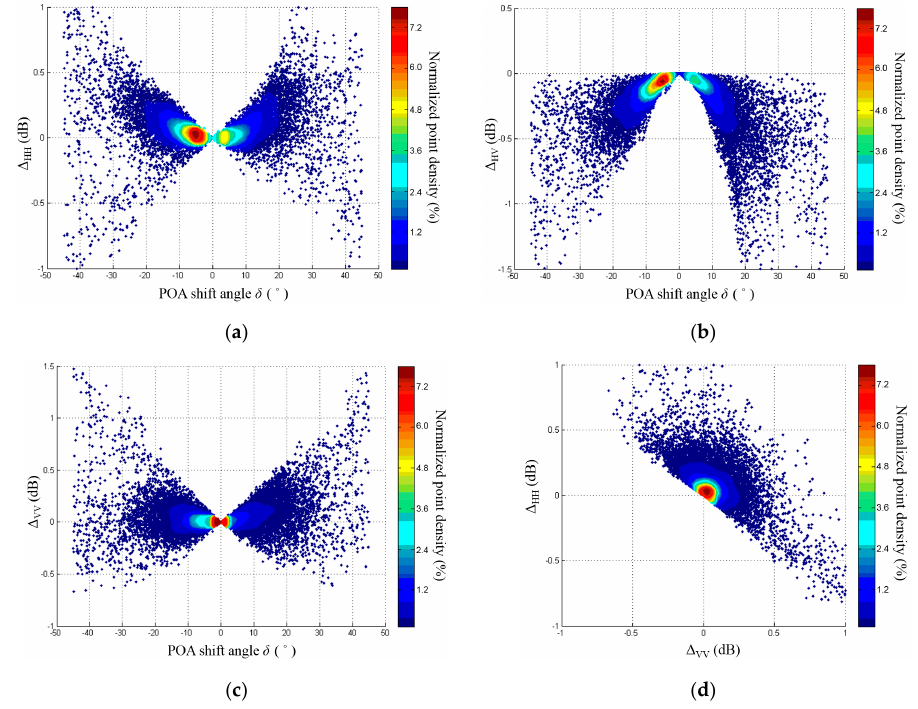
Figure 17. The relationship between the differences between corrected and uncorrected PolSAR data and the POA shift angle: ( a ) Δ HH vs. δ ; ( b ) Δ HV vs. δ ; ( c ) Δ VV vs. δ ; ( d ) Δ HH vs. Δ VV.